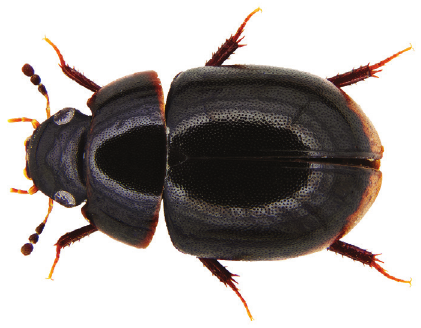
Figure 35. Coelostoma sp. 3 4.8 mm, iSimangaliso Wetland Park, Eastern Shores (site 23), February 2015 DT Bilton, MS Bird & R Perissinotto